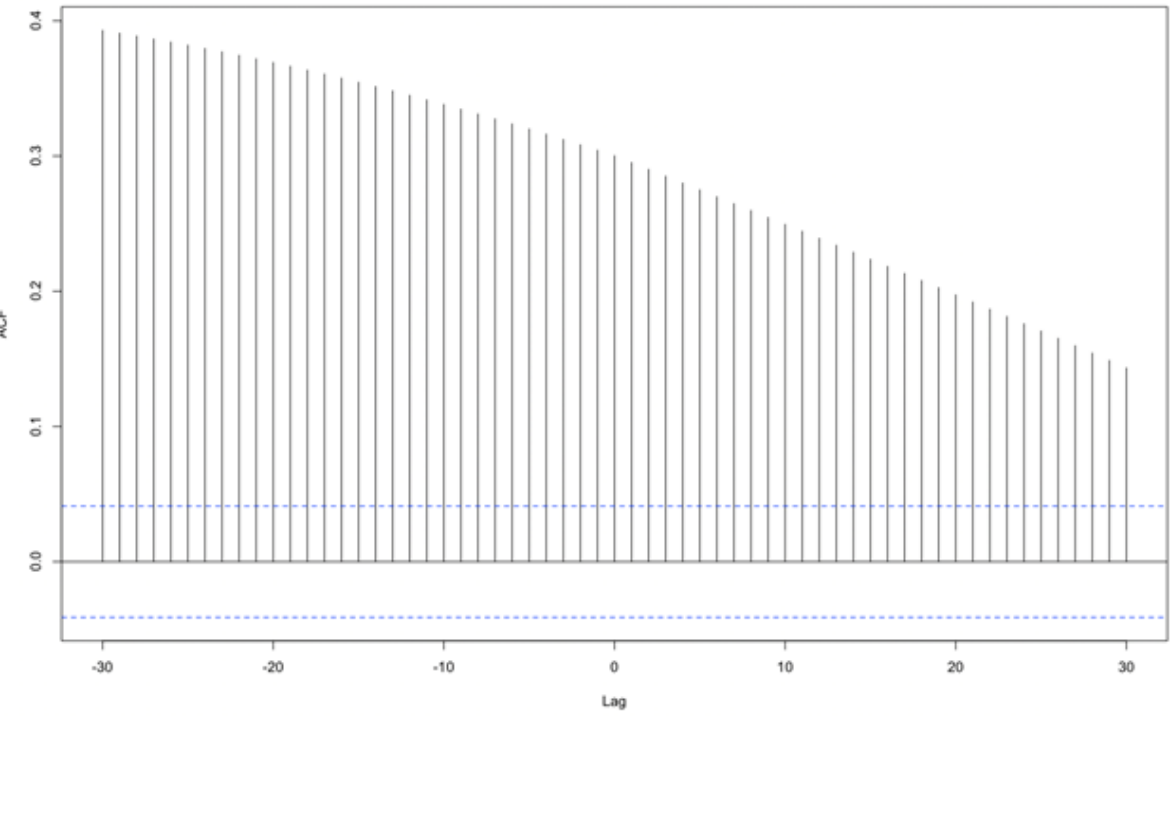
Figure 3. Cross-correlation between Google searches in Freiburg and the density of patients diagnosed with conjunctivitis (ICD code group "H10.-") in the Freiburg region. The visit density in the emergency practice lags behind the Google search. Each vertical bar corresponds to a bivariate correlation of the values at interest between both time series, with the second series shifted for the given time lag (given in days). The blue line depicts the upper limit of the correlation that one would see if one of the functions was only white noise [17]. The search frequencies are available only aggregated per month. Therefore, we had to intrapolate these data at day level before applying the cross-correlation function. ACF: autocorrelation